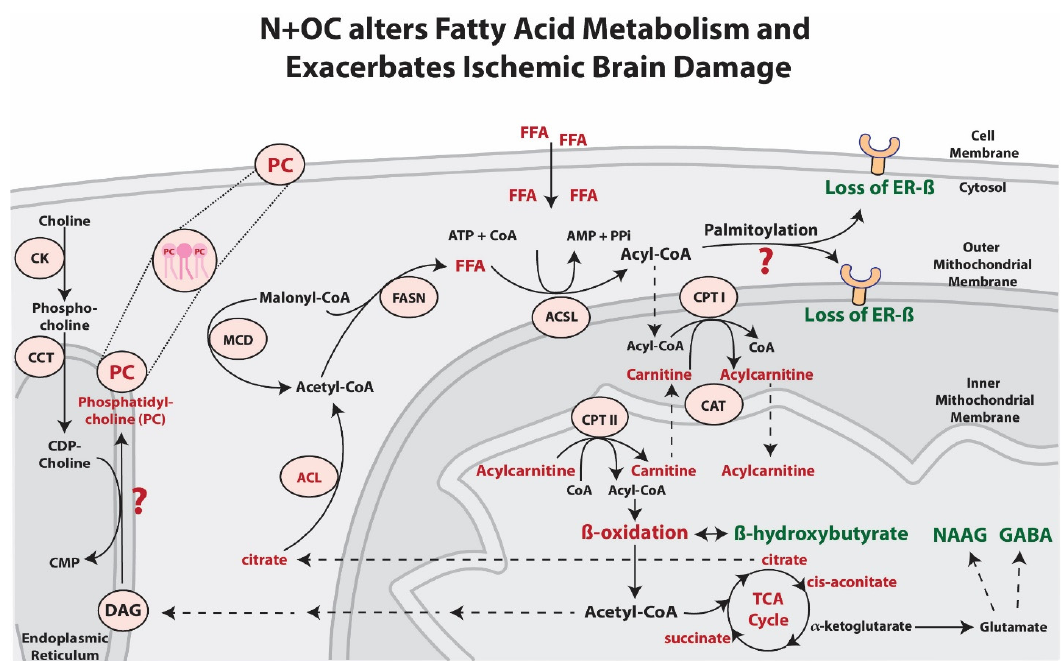
Figure 9. Putative effects of N + OC exposure on lipid metabolism leading to severe ischemic stroke outcomes. Our findings indicate that N + OC elicits an increase in free fatty acids (FFA). Acyl-CoA synthetase (ACSL) is responsible for converting FFA into acyl-CoAs at the outer mitochondrial membrane. Acyl-CoAs that pass into the mitochondria donate their acyl groups to carnitine to form acylcarnitine in a reaction facilitated by carnitine palmitoyltransferase I (CPT I). This allows carnitine in the form of acylcarnitine to be shuttled through the inner mitochondrial membrane via carnitine acylcarnitine translocase (CAT). These acylcarnitines are then converted back to carnitine by carnitine palmitoyltransferase II (CPT II). Acyl-CoA is regenerated in this mechanism inside the mitochondria where it can then be used for energy production via β -oxidation and the TCA cycle. N + OC exposure decreased levels of the ketone body β -hydroxybutyrate, suggesting that exposure to N + OC potentially initiated an energetic shift to fat metabolism. The TCA metabolite α -ketoglutarate is especially relevant as it is a primary source of synthesis for the neurotransmitter glutamate [58]. Glutamate is the precursor of the neurotransmitters N-Acetylaspartylglutamic acid (NAAG) as well as γ -Aminobutyric acid (GABA). The TCA metabolite citrate is transported outside of the mitochondria and the enzyme ATP-citrate lyase (ACL) subsequently breaks it down into acetyl-CoA and oxaloacetate. Another source of cytosolic acetyl-CoA is from the degradation of malonyl-CoA into acetyl-CoA and carbon dioxide by the enzyme malonyl-CoA decarboxylase (MCD). The enzyme fatty acid synthase (FASN) takes malonyl-CoA and acetyl-CoA and catalyzes the formation of long-chain free fatty acids. Changes in FFA levels affecting Acyl-CoA can subsequently disrupt processes dependent on these molecules such as palmitoylation, which utilizes palmitoyl- CoA as its main acyl-CoA substrate. Estrogen receptor subtype beta (ER- β ), a receptor previously implicated in neuroprotection after ischemic damage, requires palmitoylation to function [14]. Altered palmitoylation after exposure to N + OC may exacerbate ischemic brain damage. In the brain, alterations to phosphatidylcholine (PC) homeostasis due to N + OC may be of consequence as PC is the most abundant phospholipid found in cell membranes. Our study found no changes in phosphocholine cytidylyltransferase β (CCT β ) or choline kinase α (CK α ) levels in the PC synthesis pathway. Possible changes in the reaction converting to PC caused by N + OC could be the root www.mdpi.com/xxx/s1, Table S1a: Fatty Acid Synthesis and Long Chain Fatty Acid metabolites in cause of the observed increase in PC levels. Metabolites and processes depicted in green font indicate a statistically significant decrease ( p ≤ 0.05) in levels. Metabolites and processes depicted in red font indicate a statistically significant increase ( p ≤ 0.05) in levels. ?: how the effects of N + OC on palmitoylation and PC synthesis in the context of stroke are not